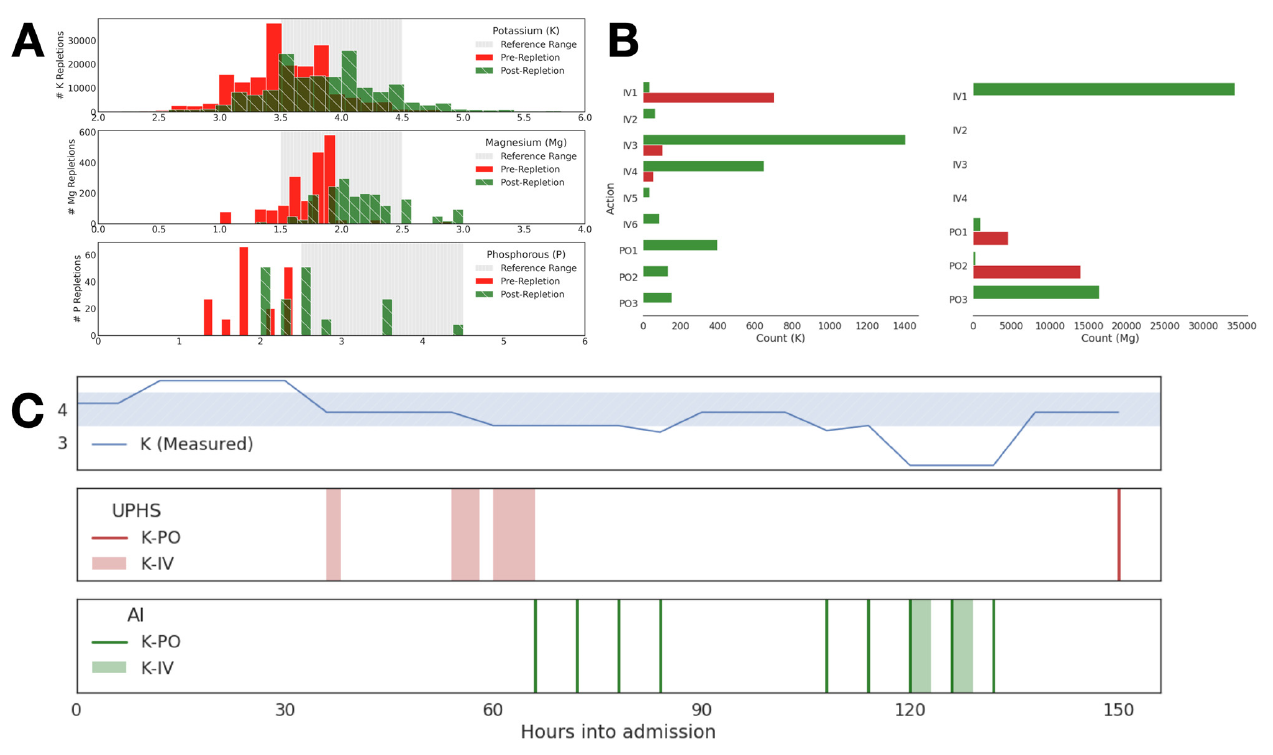
Figure 6. The performance of providers in the MIMIC database was similar to that observed in UPHS with frequent over ‐ repletion (Panel ( A )). Implementation of the RL AI ‐ driven policy resulted in an insignificant shift in repletion patterns (Panel ( B )), but only when the repletion was adequate (Panel ( C )).